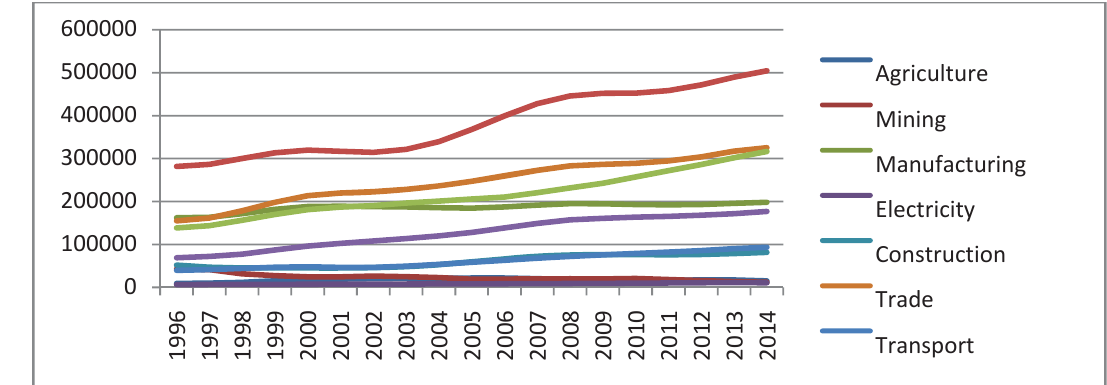
Fig. 6. COJ formal employment trends 10 sectors